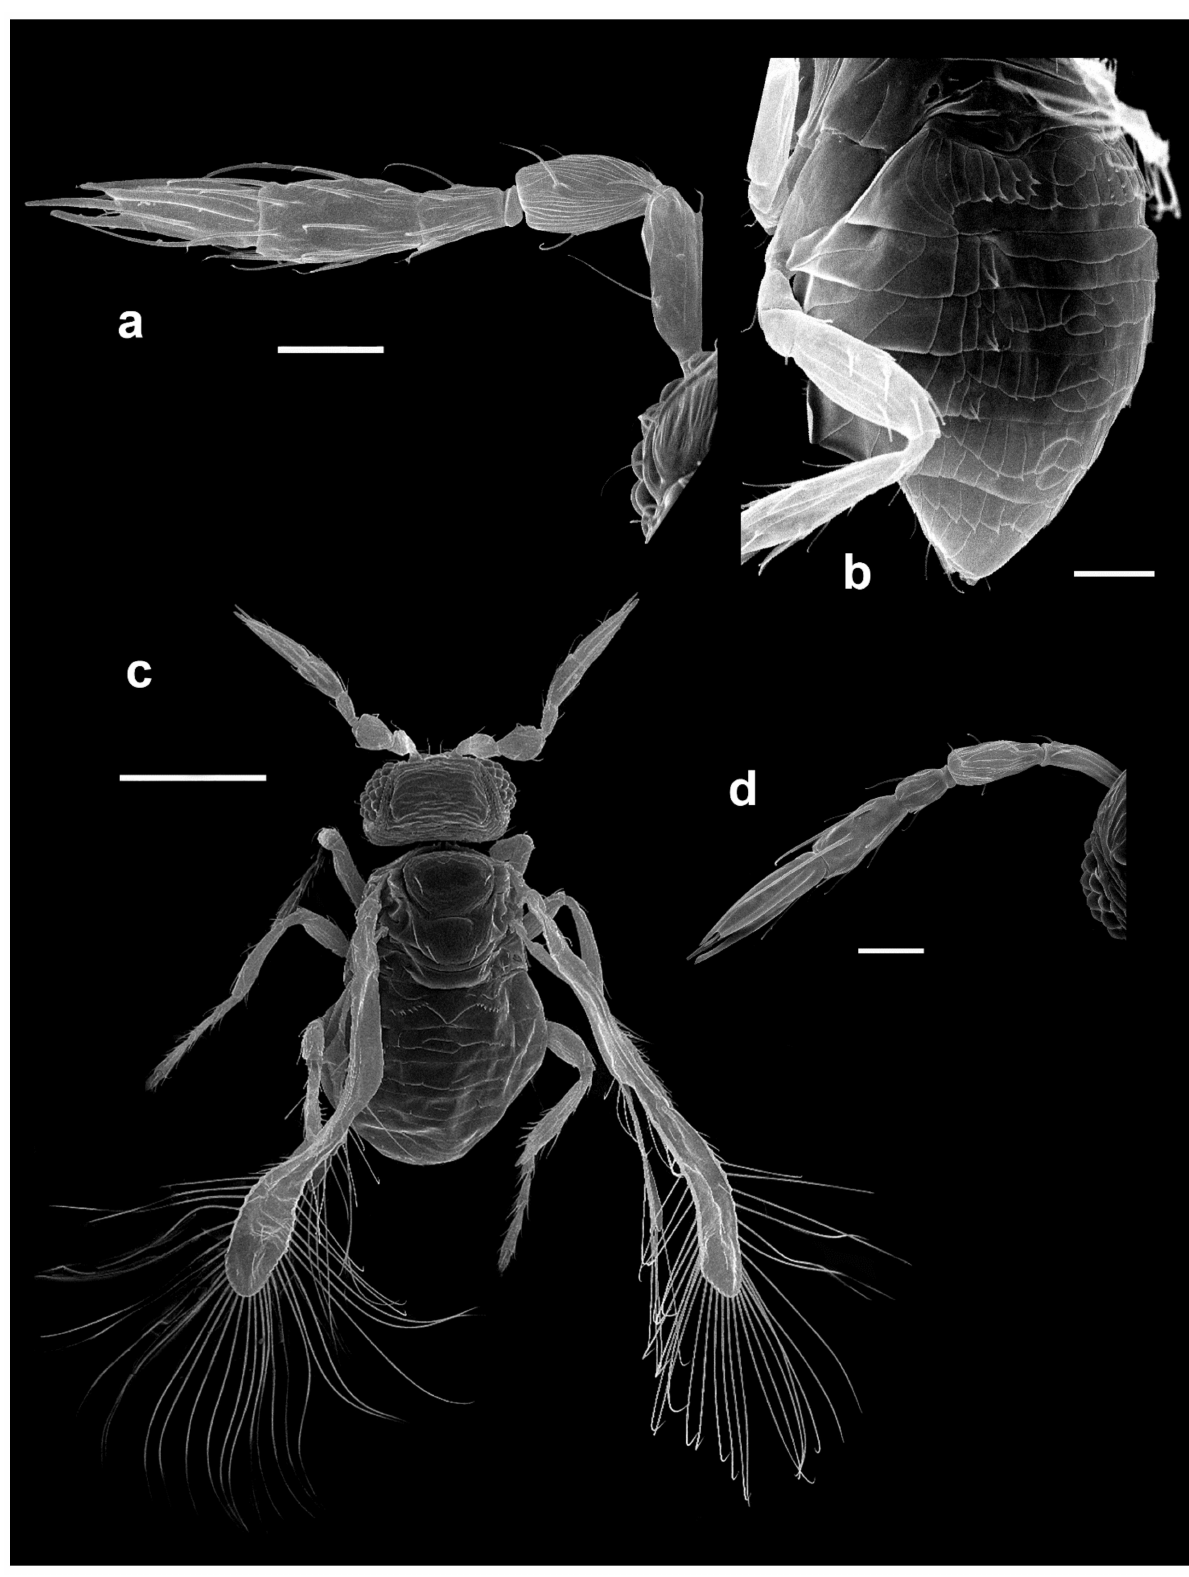
Figure 20. SEM micrographs of Megaphragma species (non-types): ( a ) M. polilovi , female antenna; ( b ) M. polilovi , female metasoma; ( c ) M. viggianii , female habitus; ( d ) M. viggianii , female antenna. Scale bars 20 µ m for a, b and d, and 100 µ m for